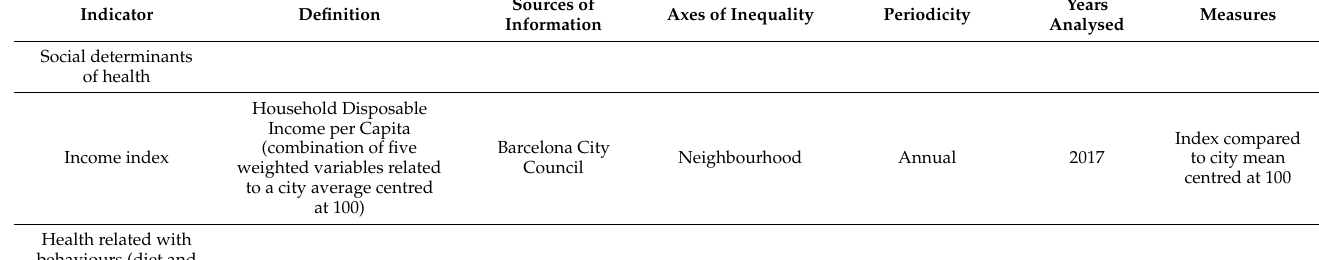
Table 1. Descriptive components of the Barcelona Social Health Inequalities Surveillance